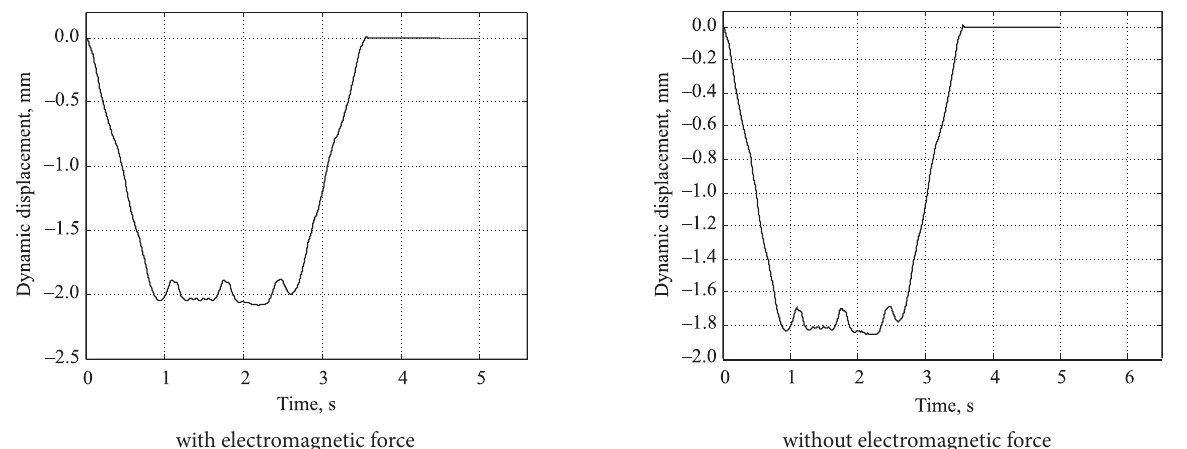
with electromagnetic force without electromagnetic force Fig. 5. Calculated dynamic displacement time-histories of 30 m simply supported bridge for velocity 100 km/h a